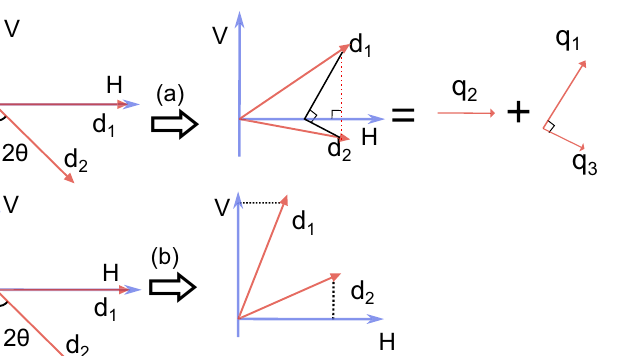
Fig. 1 Geometric representation of the principles of nonortho- gonal state discrimination. Principles of ( a ) unambiguous quantum state discrimination (UQSD) and ( b ) minimum error discrimination (MED) strategies. The moduli of the vectors represent the square roots of the a priori probabilities of the states. In UQSD, the states d